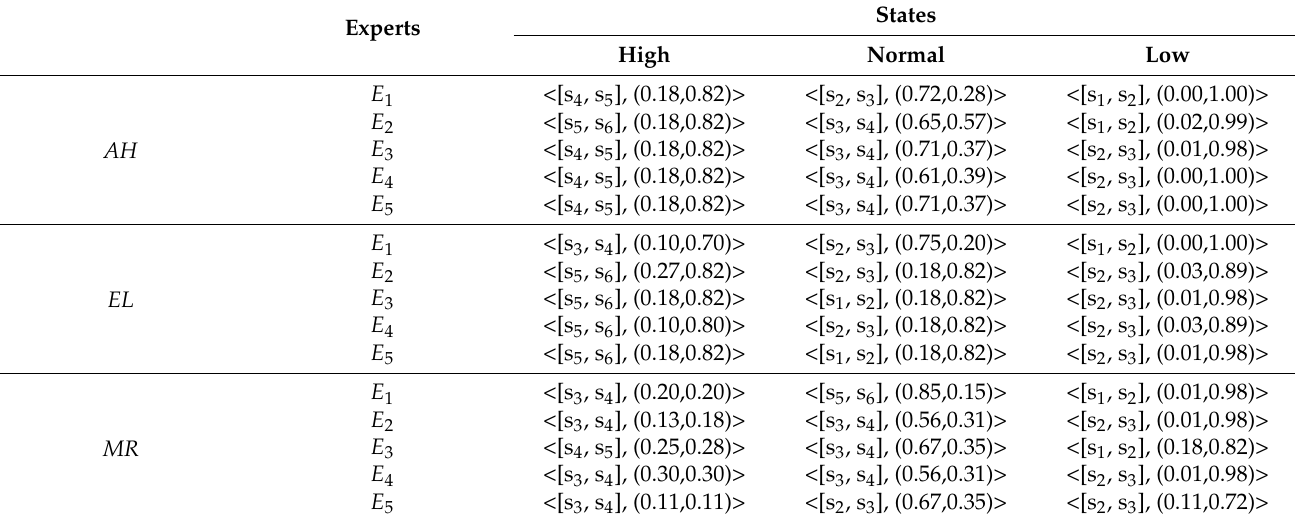
Table 2. The knowledge assessment matrix on parameter b ij by the